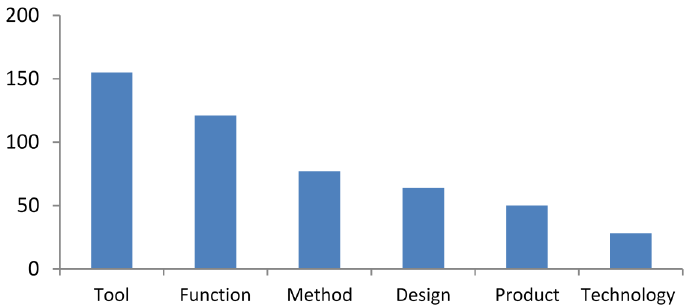
Figure 1. Innovation classification based on